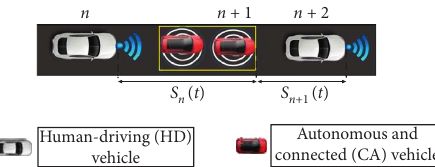
Figure 1: The mixed traffic flow including AC vehicles platoon and HD vehicles